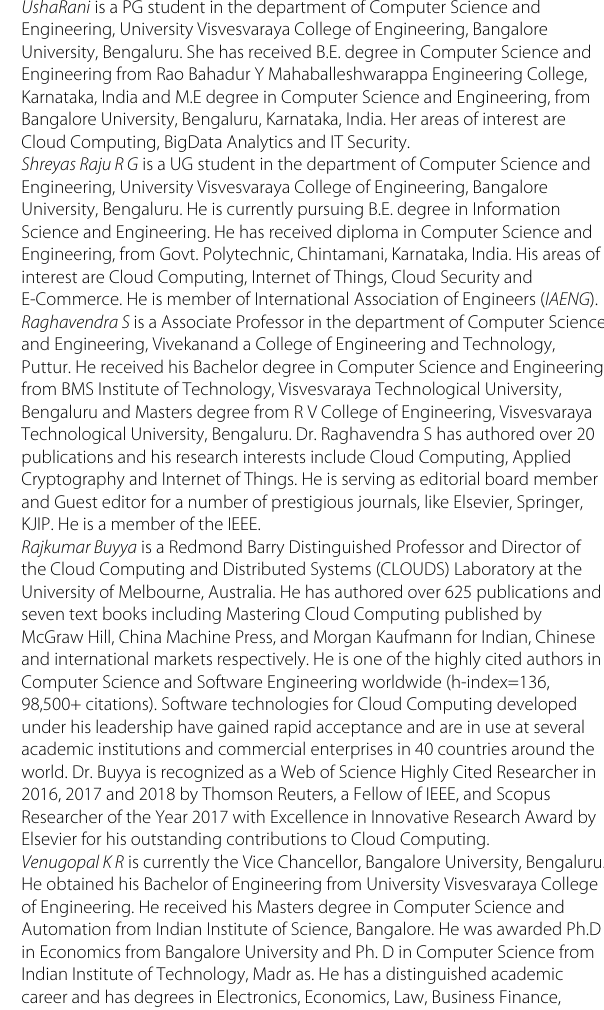
Fig. 10 Processing time for different block numbers in the Setup phase